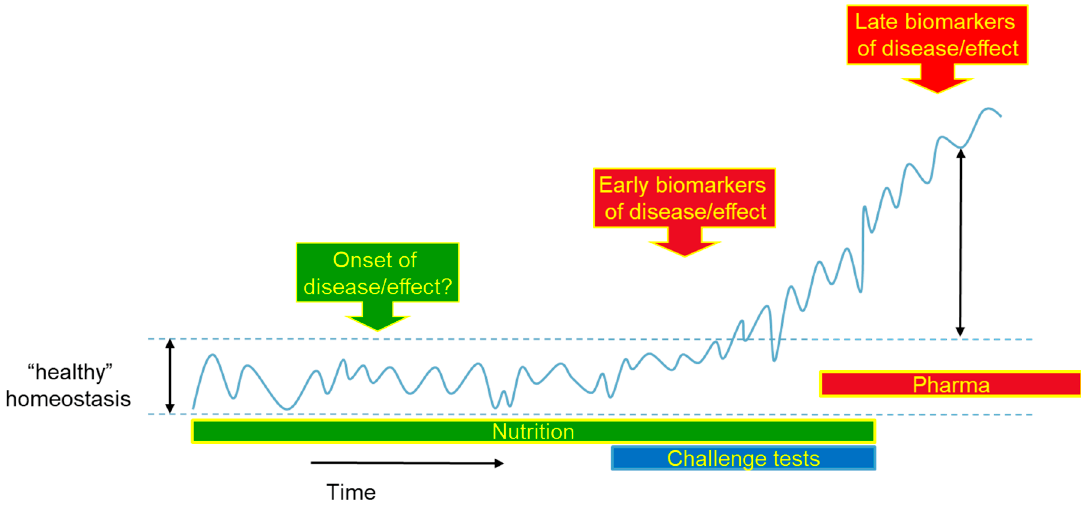
Figure 1. Biomarker sequel from optimal healthy towards disease. In optimal health, a biomarker will show very dynamic behavior within certain normal boundaries. This dynamic behavior is the result of adaptation to daily stressors, such as eating, exercising etc. This dynamic biomarker behavior will start to change in a pre-stage of disease where dynamics of these early biomarkers of disease or effect will just move outside these normal boundaries. When full blown disease develops and progresses, biomarkers will have very different dynamics, as well as different offset values. These so-called late biomarkers of disease or effects are currently mainly in use especially by pharma and health care, which makes sense since they are aiming to show that treatments are beneficial to disease state. However, nutrition is aimed at the maintenance of health or prevention of disease. Reproduced with permission from [58].